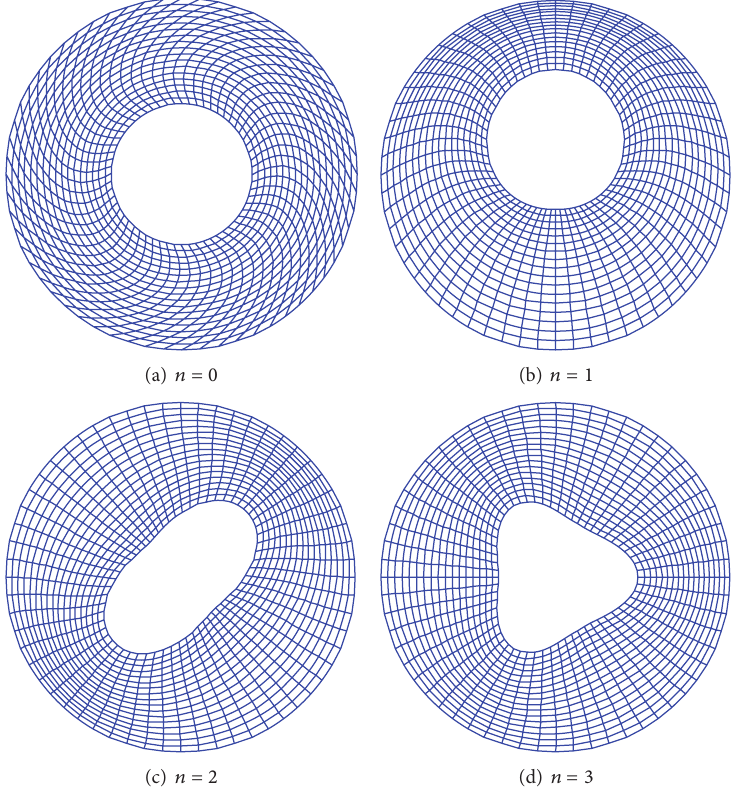
Figure 2: Mode shapes for F-C annular plate (𝑎/𝑏 = 0.4) with 𝑛 = 0 , 1, 2, and 3.